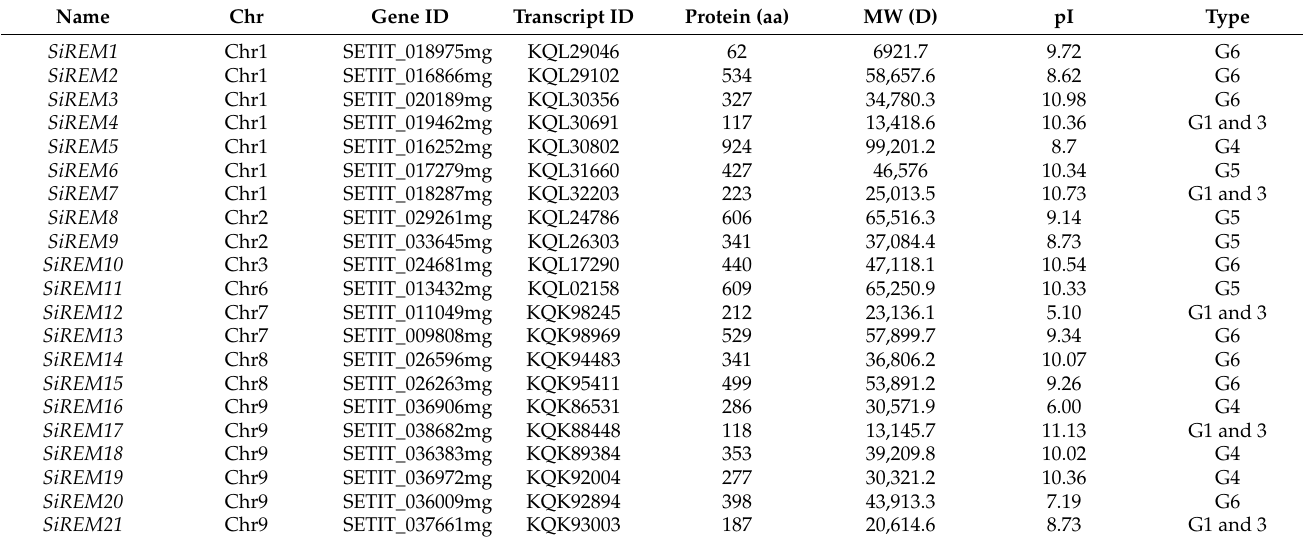
Table 1. The identification of remorin members in foxtail